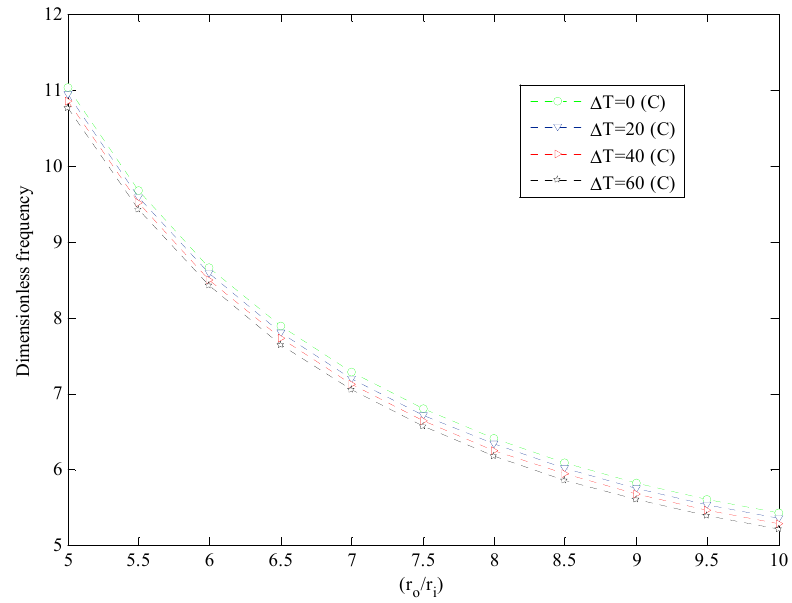
Figure 8. Dimensionless frequency versus radial ratio for different variations in temperature.